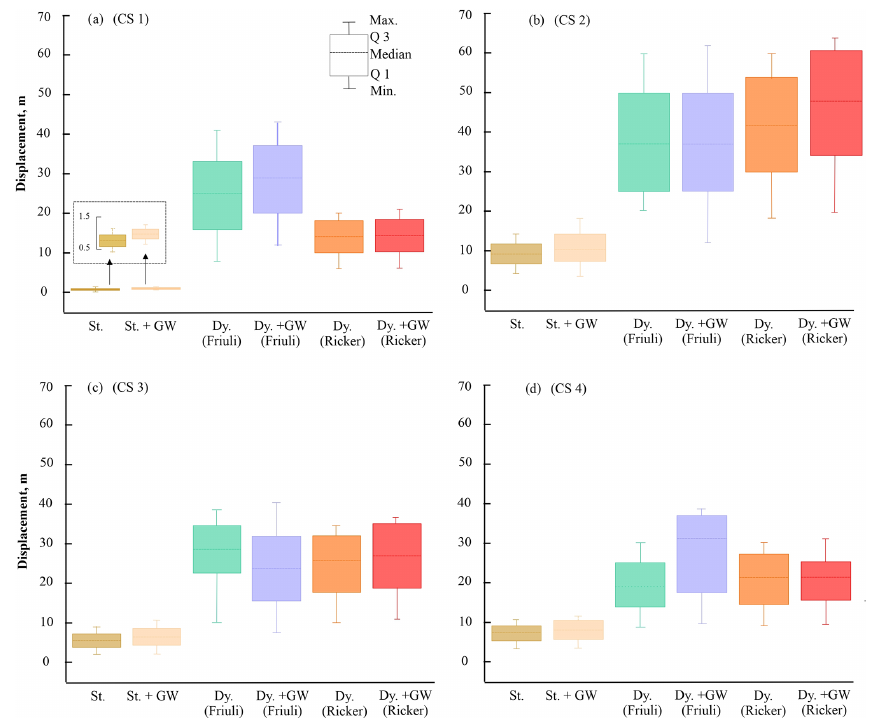
Figure 9. Comparison of material displacement under different conditions. St. and Dy. refer to static and dynamic conditions, respectively. GW refers to